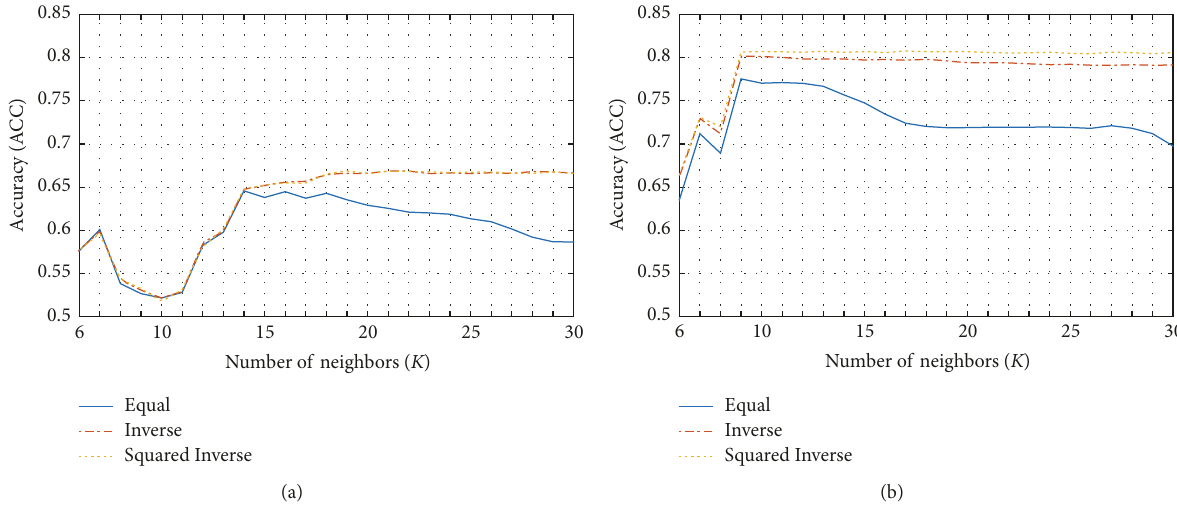
Figure 4: Evolution of accuracy levels as a function of the number of neighbors using distance weighting function Equal, Inverse, and Squared Inverse: (a) weekday data and (b) weekday-weekend